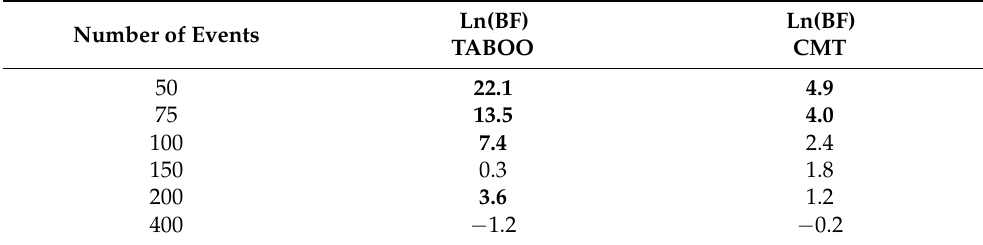
Figure 3. MLE of α for the TABOO ( a ) and CMT ( b ) learning catalogues. Table 1. Bayes Factor (BF) for the comparison of fixed number b-value estimation and the weighted likelihood approach for TABOO (2nd column) and CMT (3rd column) catalogues; bold is used for “strong evidence” of the BF (ln(BF) > 3).